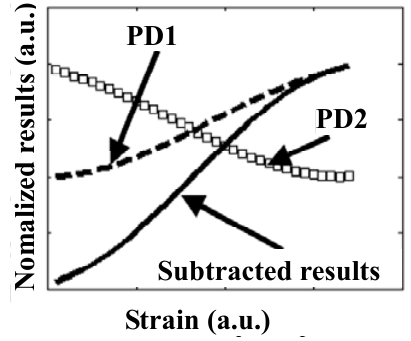
Figure 3. Principle of DP-FBG demodulation with detected power